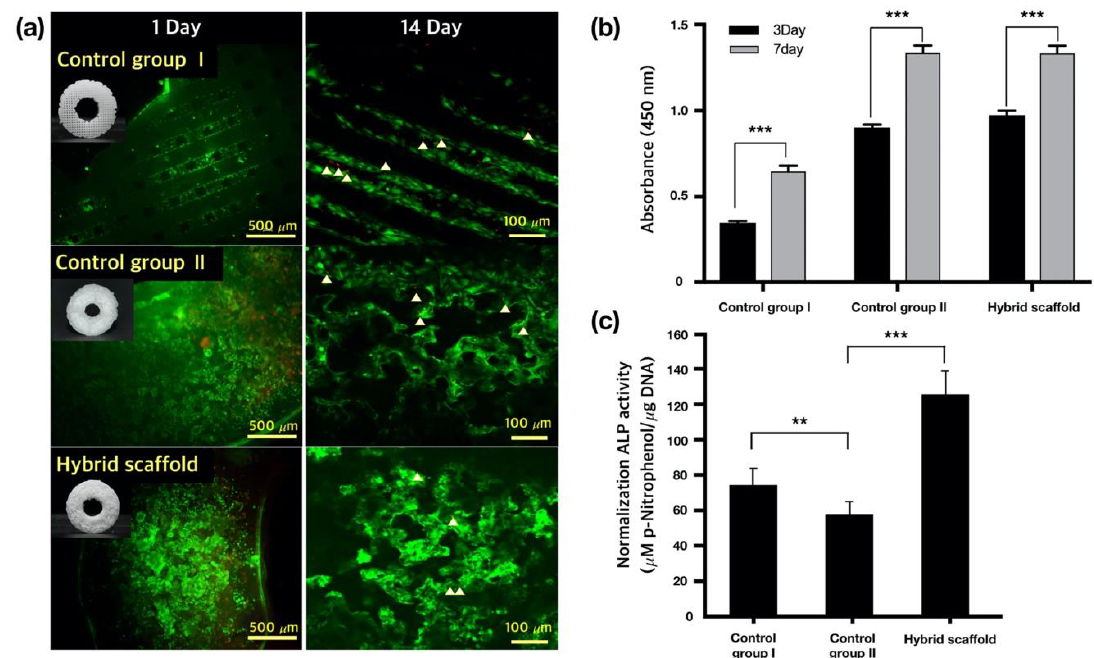
Figure 7. ( a ) Live/dead assays of three groups 1 day (magnification: ×100) or 14 days (magnification: × 200) after cell seeding (white triangle: dead cells), ( b ) CCK-8 assays of the three groups (*** p < 0.0005), ( c ) alkaline phosphatase (ALP) activities of Saos-2 cells seeded on different scaffolds 14 days after culture (** p < 0.005, *** p < 0.0005).